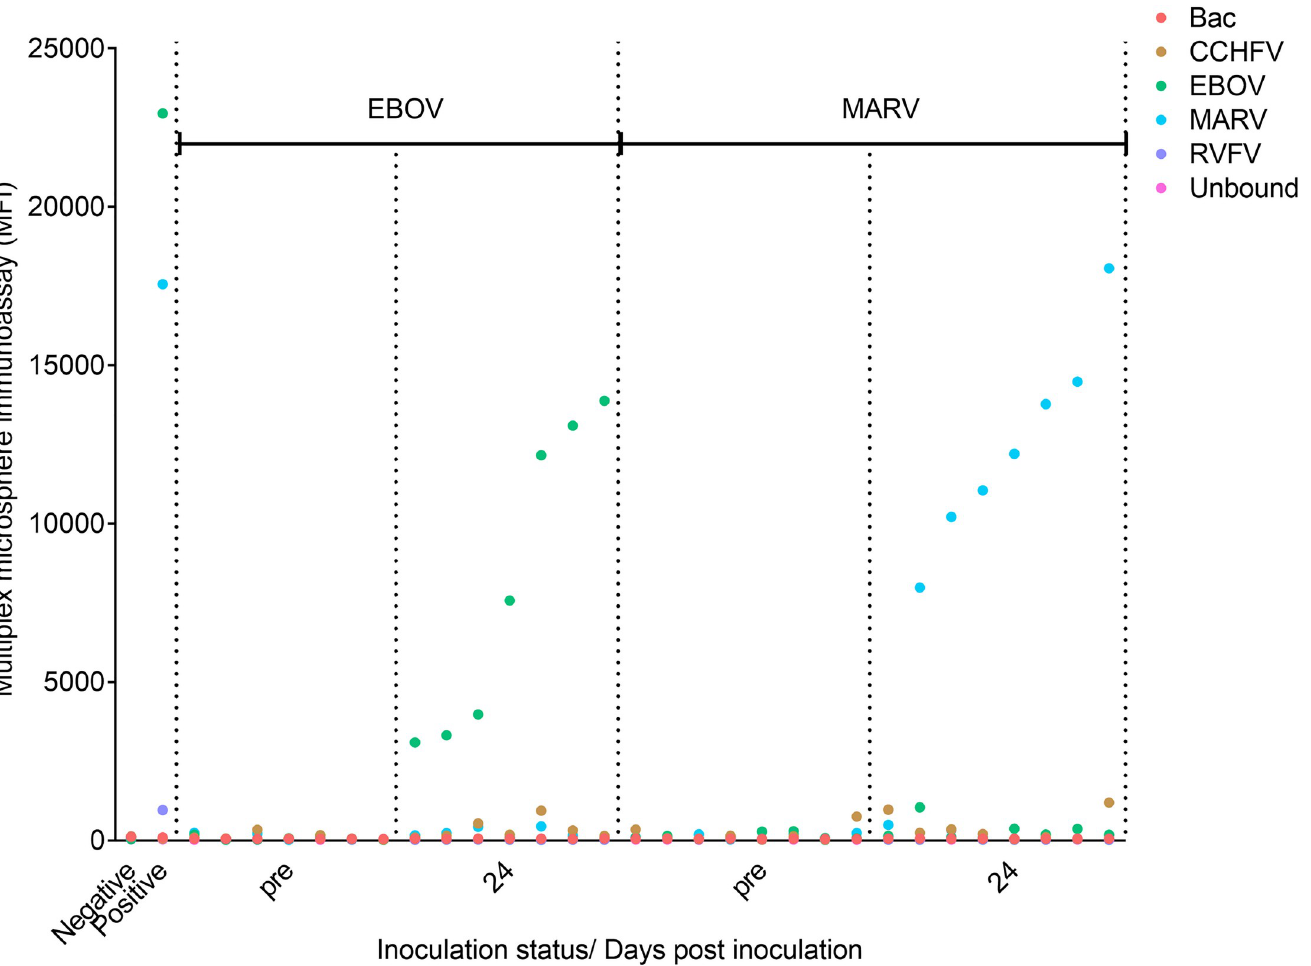
Fig 4. Analysis by MMIA of serum samples taken pre- and post-inoculation with EBOV- and MARV-VLPs from Mops condylurus micro bats. Serum samples were taken from micro bats 24 days after inoculation with EBOV VLPs and MARV VLPs, and their reactivity to EBOV NP and MARV NP coupled microspheres was compared to sera taken pre-inoculation. The MMIA was adapted to detect bat antibodies by exchanging the SAPE-conjugated anti-human secondary antibody with SAPE-conjugated protein A and protein G. MFI readings for the same negative and EBOV-NP and MARV-NP positive NHP sera used as controls in all MMIAs are shown in the first 2